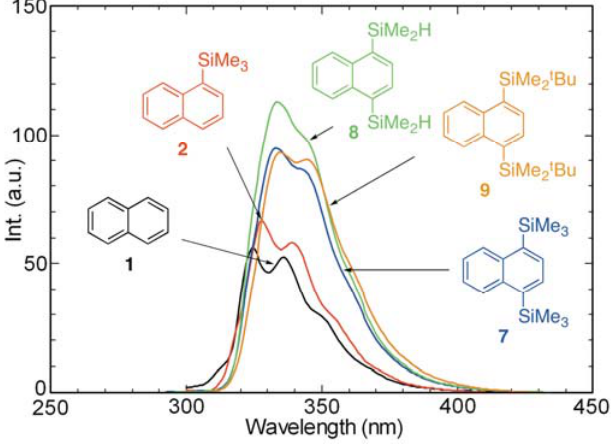
Figure 5. Fluorescence spectra of 1 , 2 , and 7–9 in cyclohexane (aerated, ca. 10 − 4 M).